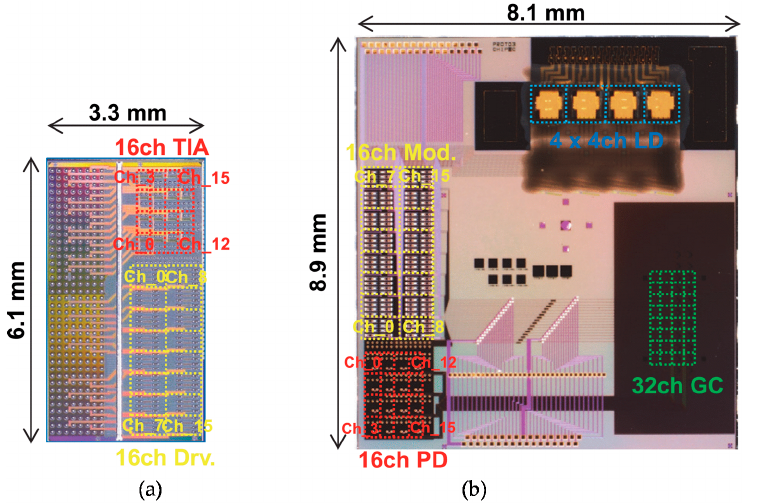
Figure 11. Photographs of ( a ) electronic integrated circuit (EIC) and ( b ) photonic integrated circuit (PIC) of the high-density 16 channels optical transceivers where transmitter and receiver elements were highly integrated in the chips; 4 × 4 channels laser diodes (LDs) were assembled and 32 channels (32ch) grating couplers (GCs) were formed in the PIC; Ch_1: the first channel; Ch_2: the second channel; TIA: trans-impedance amplifier; (From [28] © 2021 IEEE).